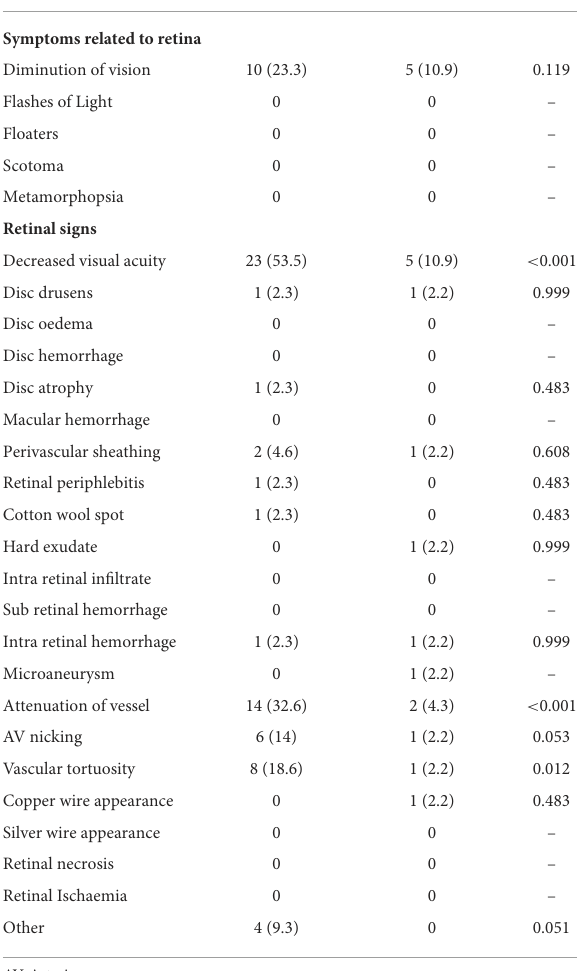
TABLE 2 Distribution of ocular symptoms and retinal signs and symptoms between IIM patients and healthy controls. Variables